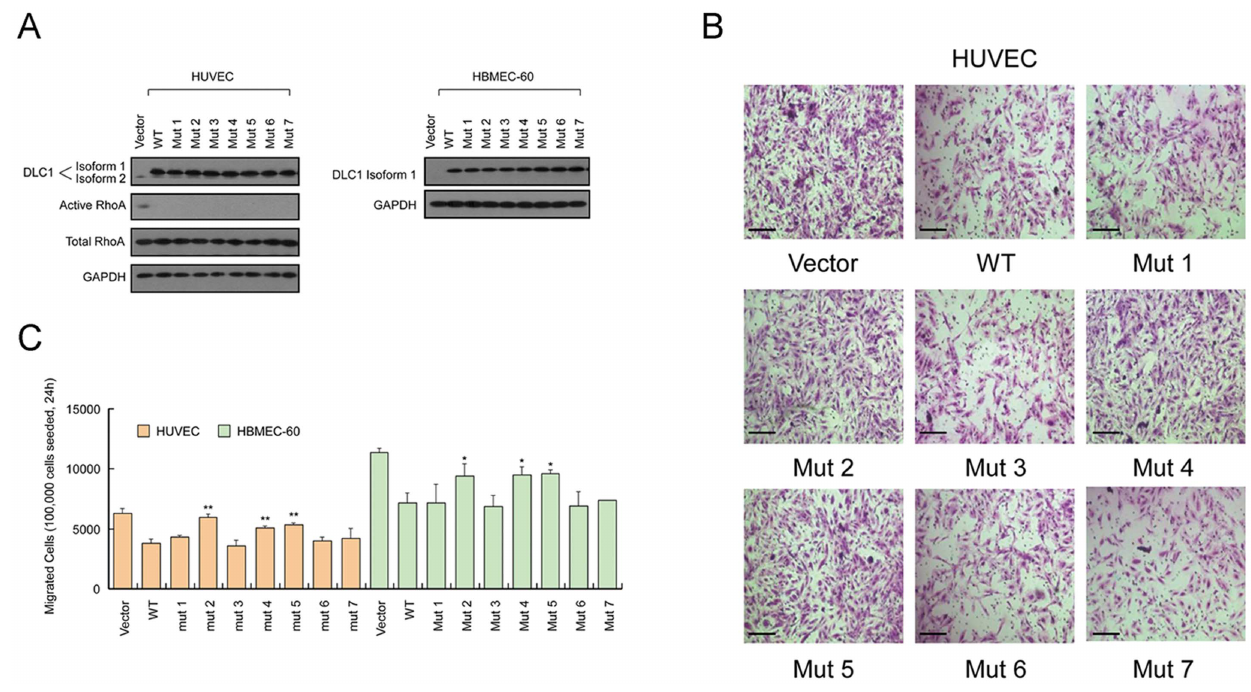
Figure 2. DLC1 isoform 1 mutants had different effects on cell migration compared with the wild type protein. (A) Western blot analyses of DLC1 isoform 1 mutant overexpression in two endothelial cell lines, HUVEC and HBMEC-60. In HUVECs, the effect of DLC1 isoform 1 mutation on the GAP activity of the protein was detected by western blotting. (B) Representative images of the Transwell migration assay using HUVECs cells are shown. (C) The quantification of HUVEC and HBMEC-60 migration showed significant differences between wild-type DLC1 and Mutants 2, 4 and 5, whereas the other mutants showed no significant difference from wild-type DLC1. Wild-type DLC1 also showed an inhibitory effect on cell migration compared to the control vector. *Student’s t-test P v 0 : 05 ; ** P v 0 : 01 . Scale bars, 100 m m. Ns, not